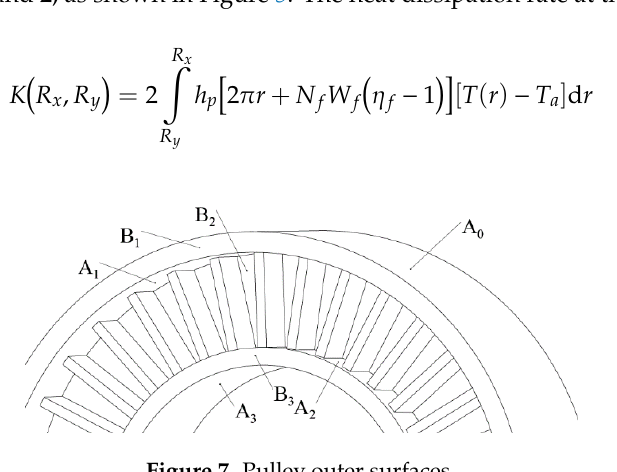
Figure 7. Pulley outer surfaces.